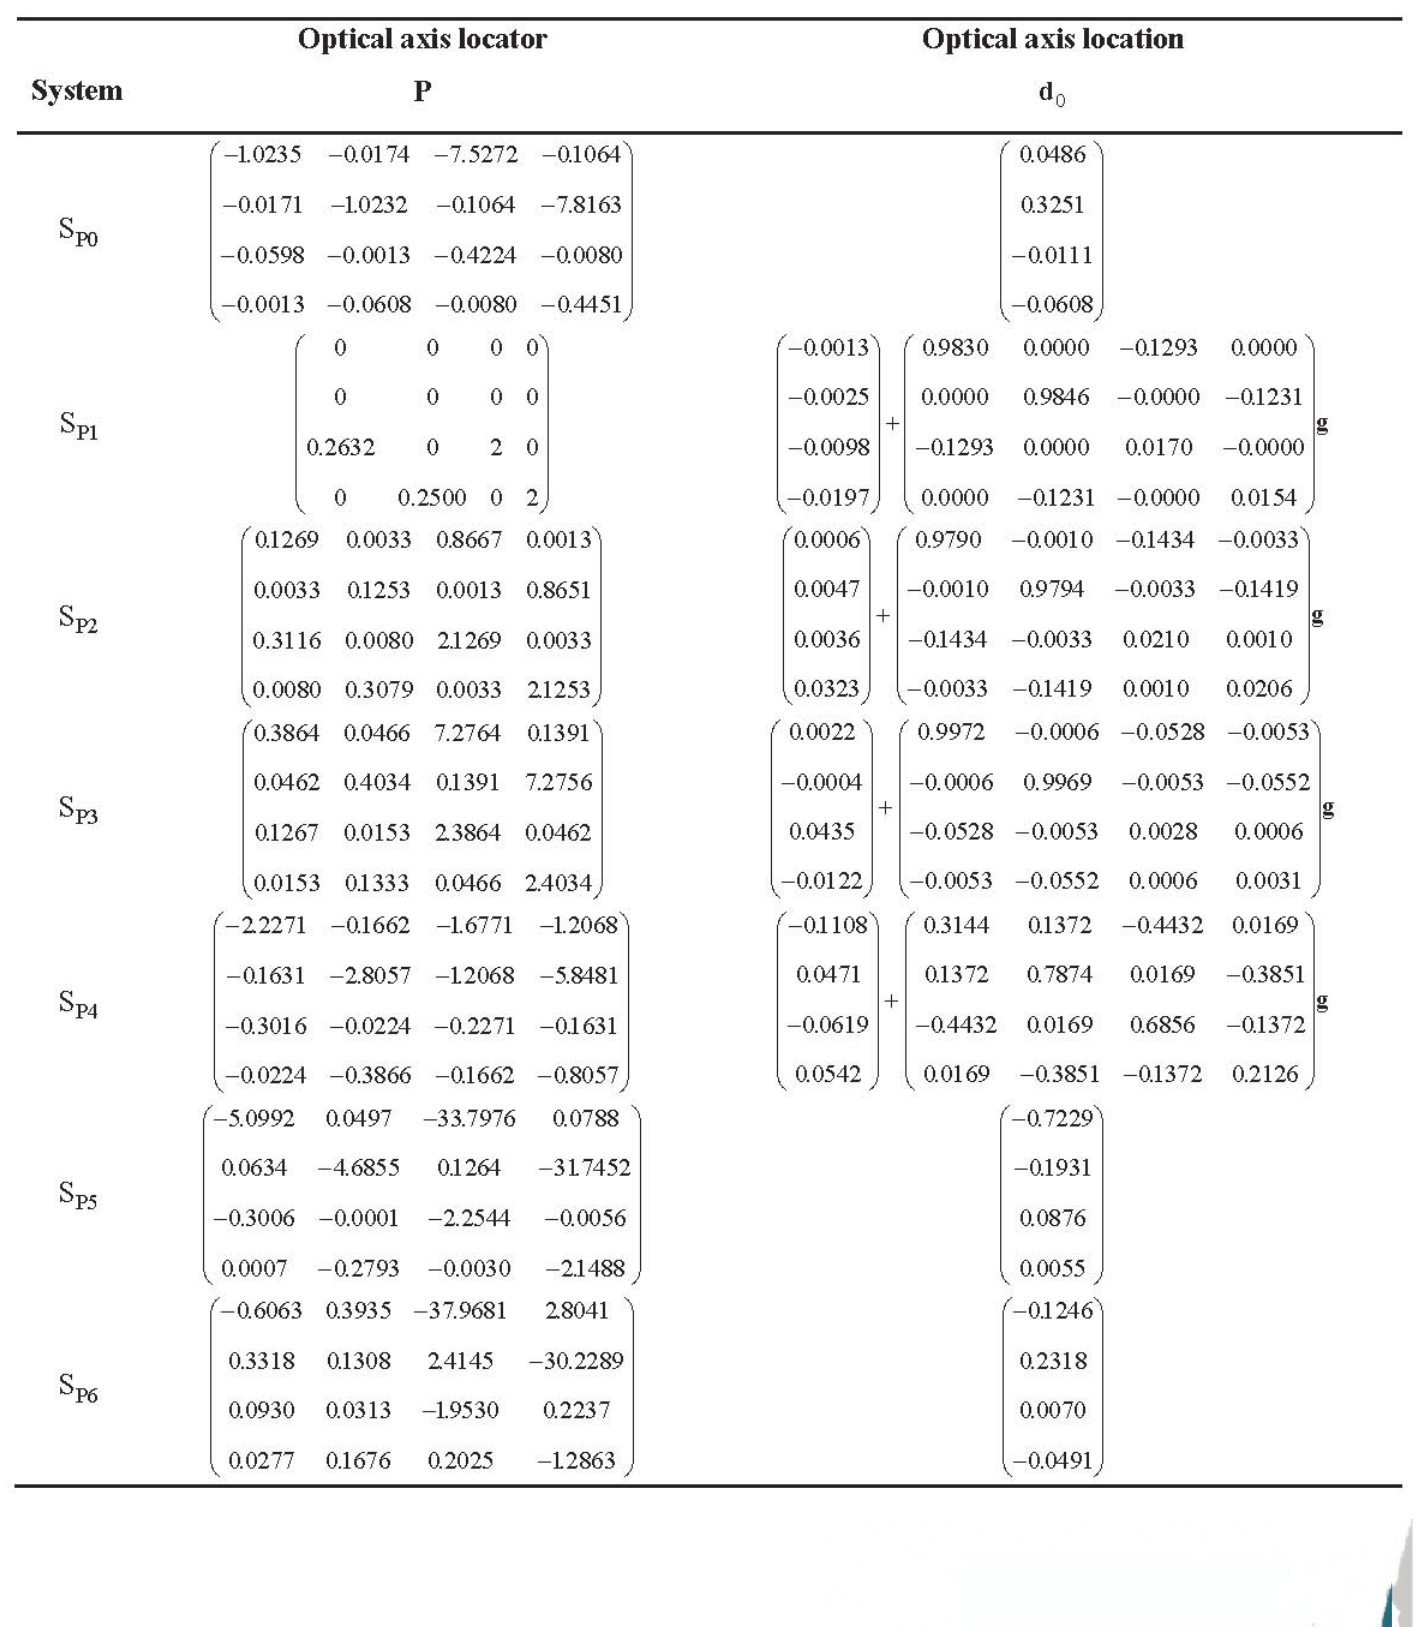
of the optical axes of seven optical systems in a heterocentric astigmatic model eye. 0 are in millimetres and entries in the bottom-left block of 0